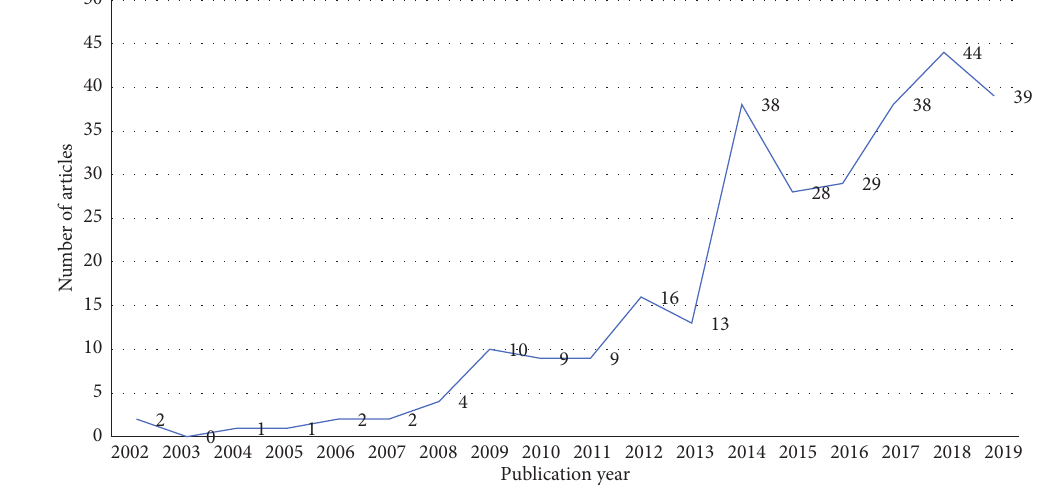
Figure 2: The number of articles on project governance in 2002–2019. Table 1: Top 8 most productive authors in project governance research.